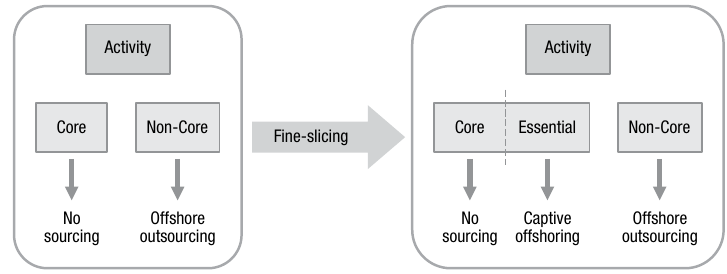
Fig. 4. Evolution of the decision process regarding which activities to